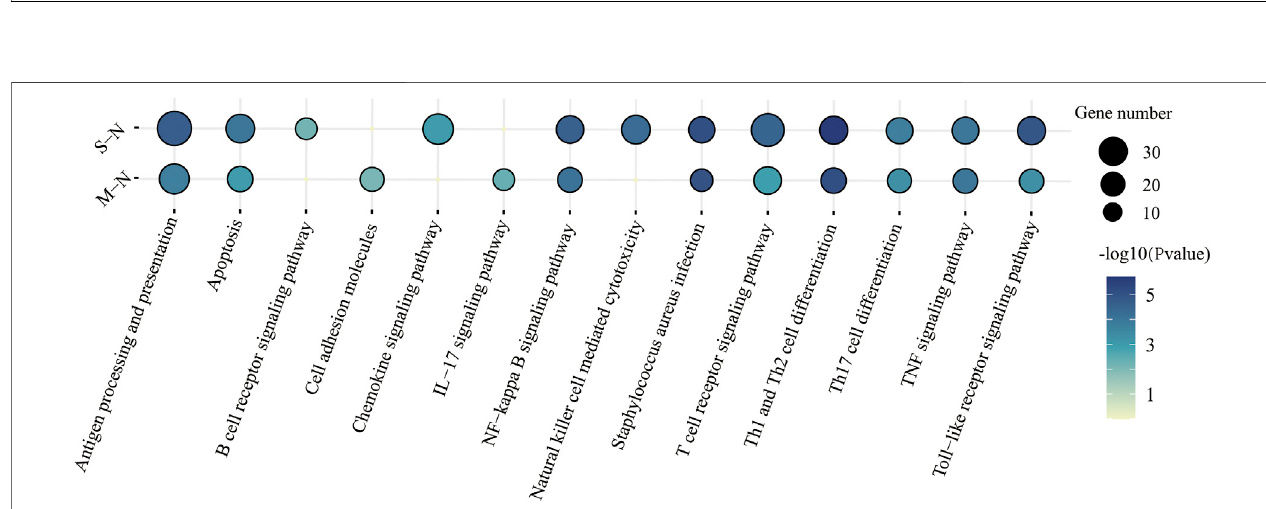
Frontiers in Molecular Biosciences |